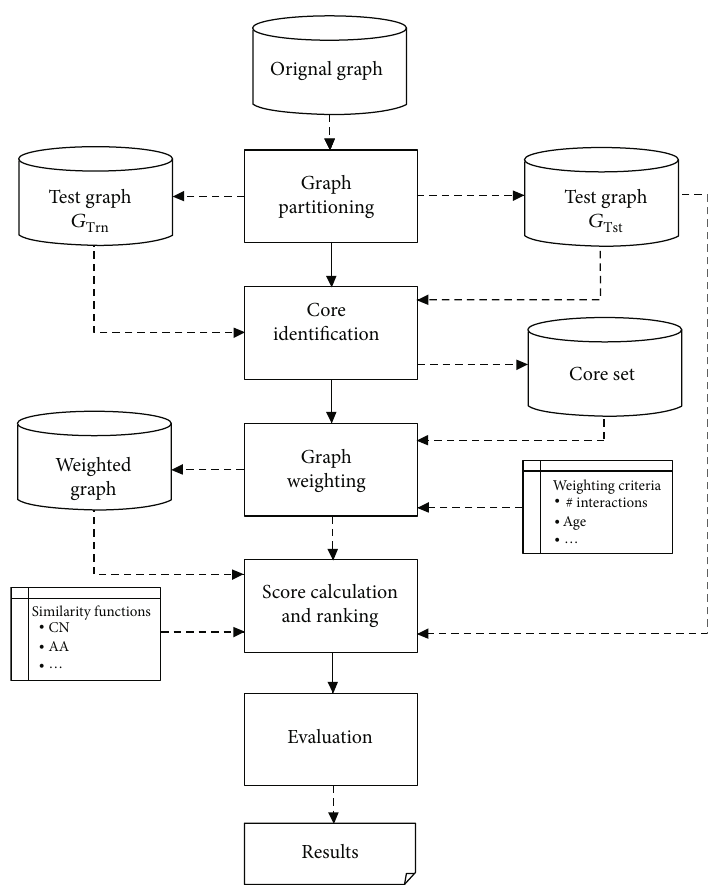
Figure 2: Unsupervised link-based link prediction indicating the fi ve core activities of method P . Table 1: Supervised vs. unsupervised